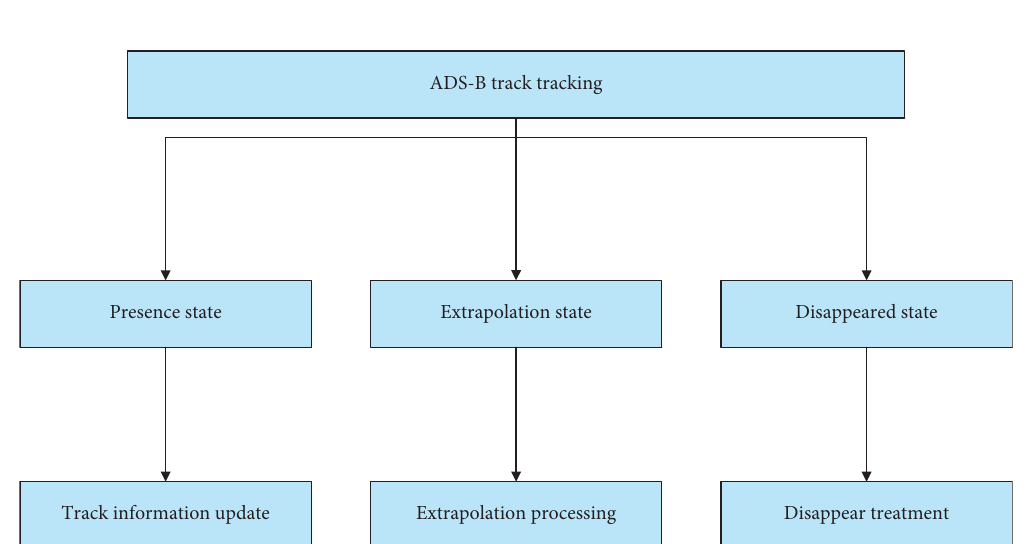
Figure 5: Schematic diagram of ADS-B track tracking